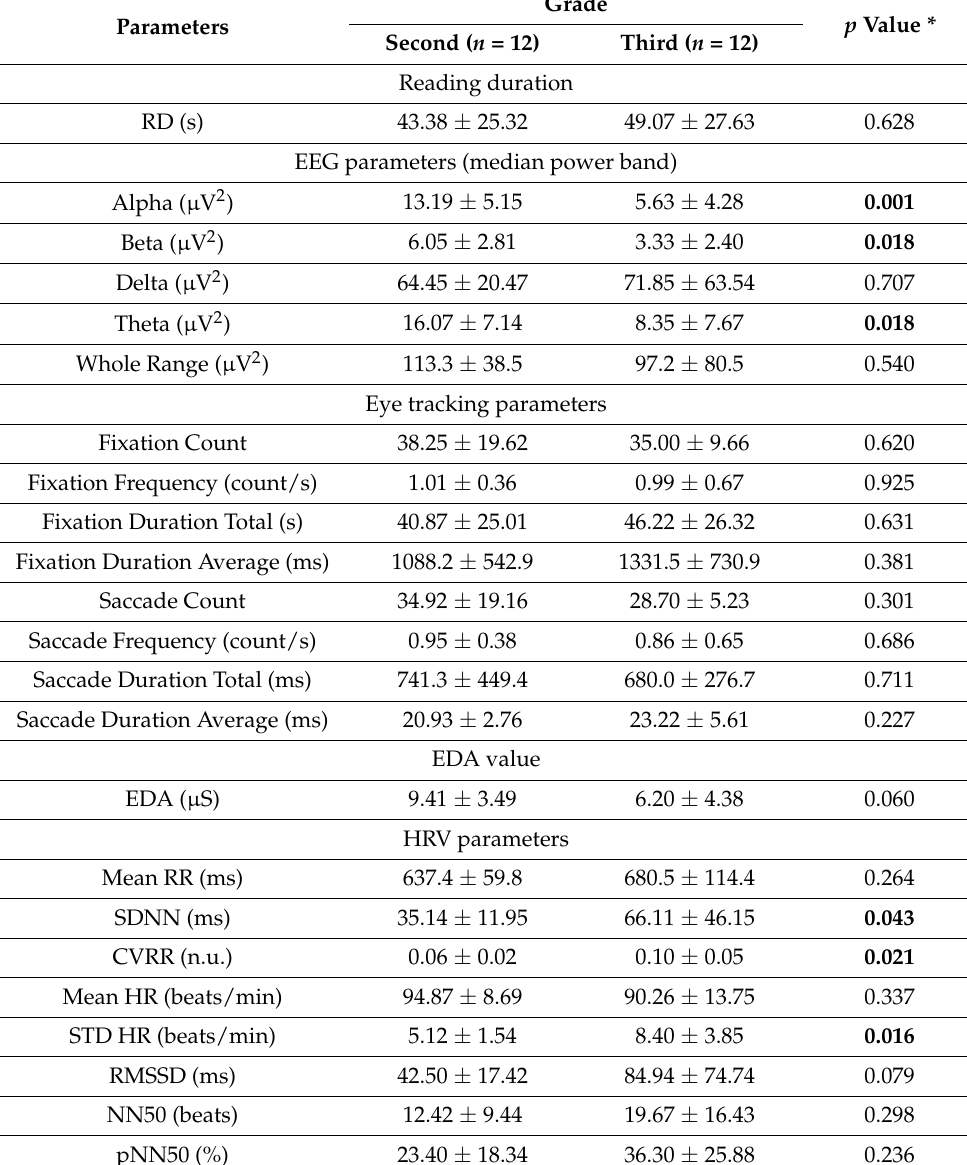
Table 2. Reading duration, EEG, eye tracking, EDA and HRV parameters in second and third grade— significant p values are marked as